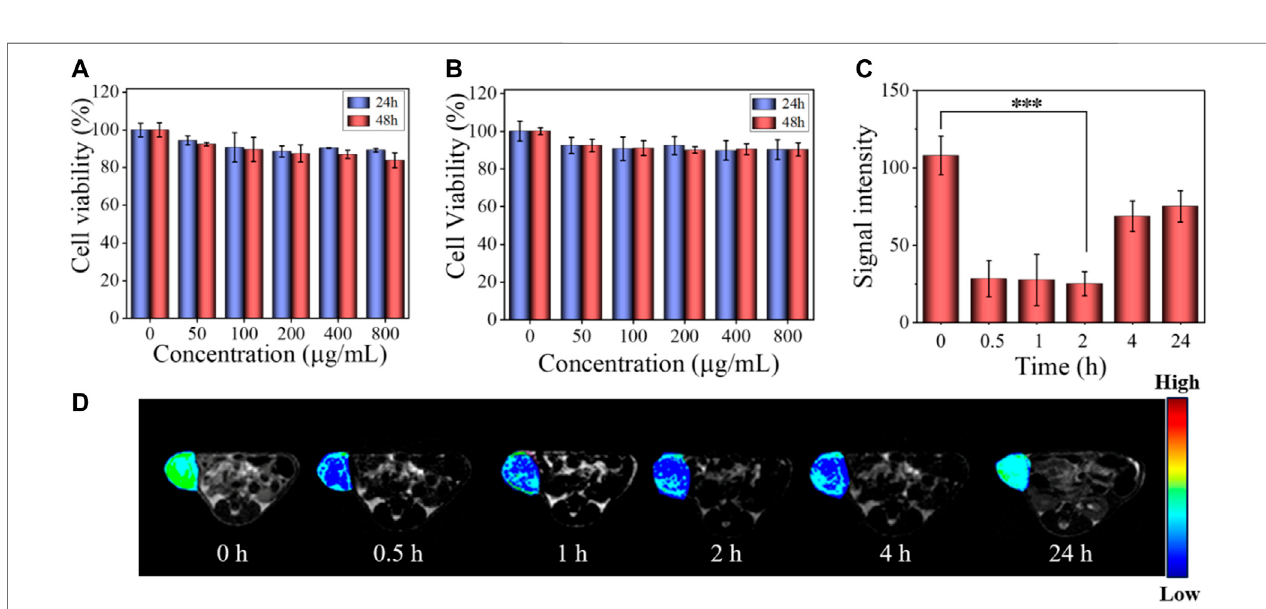
FIGURE5|(A) Viability ofHeLacellsafter incubatingwithSPNs for24and 48 h.Thedataaregivenasmean±SD( n =5). (B) ViabilityofHeLacellsafter incubating with SSPNs for 24 and 48 h ( n = 5). (C) Signal intensity of in vivo MR imaging corresponding to (D) ( n = 3,*** p < 0.001, ** p < 0.01, * p < 0.05). (D) In vivo MR images of tumor after intravenous injection of SSPNs (100 μ l, 10 mg ml − 1 ) at different times.